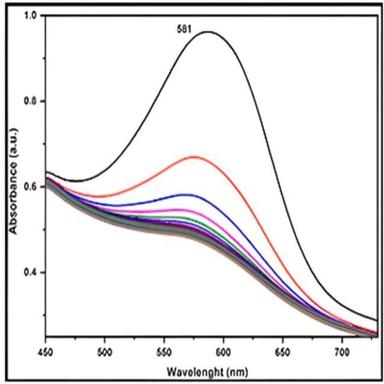
Demonstration of the photodegradation process of methylene blue in the presence of MTZ -ZnMoO4 nanocomposite at 581 nm wavelength for up to 170 minutes.